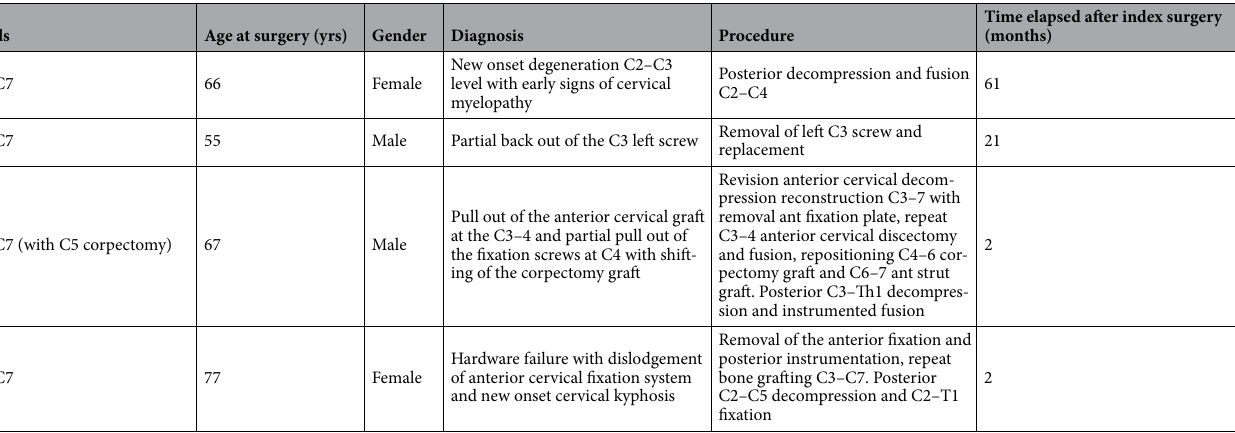
Table 4. Patients with four-level ACDF requiring revision surgery. ACDF anterior cervical discectomy and